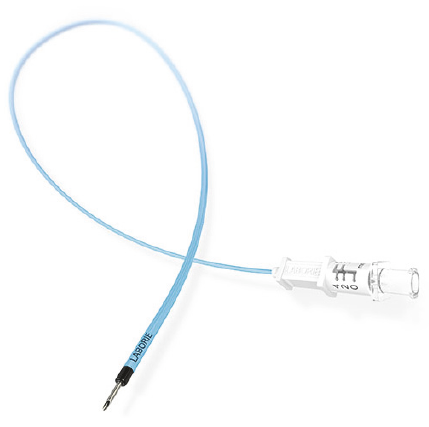
Figure 1: Laborie injeTAK (cid:2) (Williston, VT) needle.